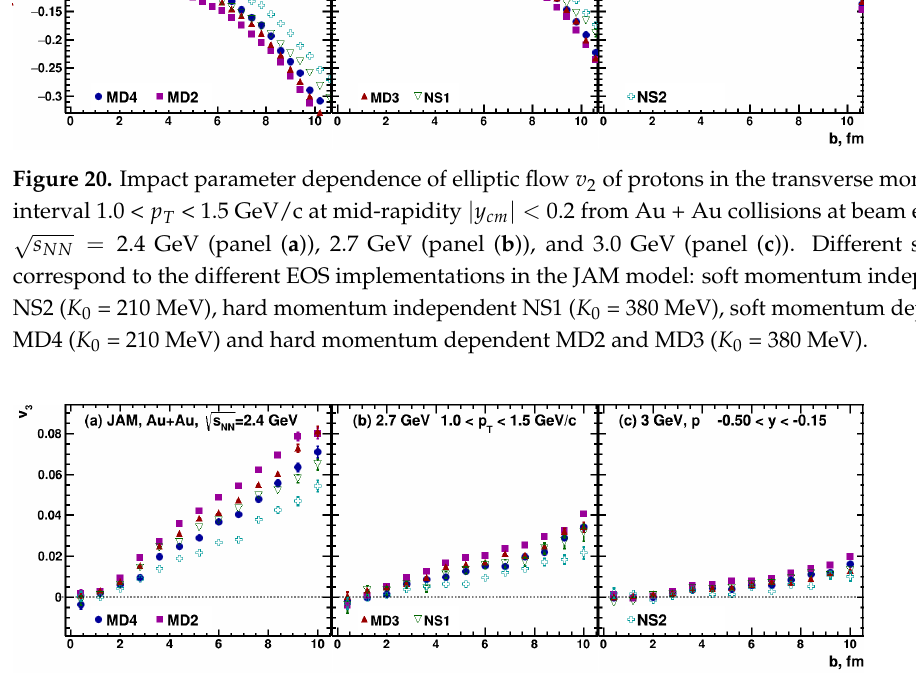
Figure 21. Impact parameter dependence of triangular flow v 3 of protons in the transverse momentum interval 1.0 < p T < 1.5 GeV/c and rapidity interval − 0.5 < | y cm | < -0.15 from Au + Au collisions at √ s NN = 2.4 GeV (panel ( a )), 2.7 GeV (panel ( b )), and 3.0 GeV (panel ( c )). Different beam energies symbols correspond to the different EOS implementations in the JAM model: soft momentum independent NS2 ( K 0 = 210 MeV), hard momentum independent NS1 ( K 0 = 380 MeV), soft momentum dependent MD4 ( K 0 = 210 MeV) and hard momentum dependent MD2 and MD3 ( K 0 = 380